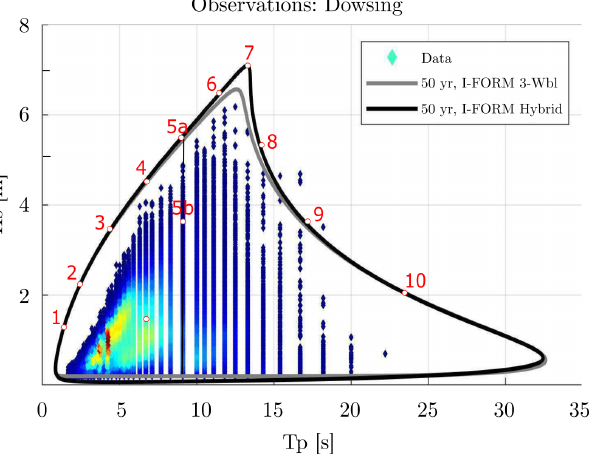
Figure 2. The 50-year return period environmental contour for Dowsing site adapted from [14]. The environmental contour, as calculated from I-FORM Hybrid method (black line), is utilized here. The contour line is discretized in 10 sea states plus one sea state (5b) inside the contour. Sea state 5b is selected so as to make the comparison between sea states with the same peak period, T p , (5a vs. 5b) and sea states with the same significant wave height, H s , (5b vs. 9). In the present study, sea states 5a, 5b, 6, 7, 8, and 9 are